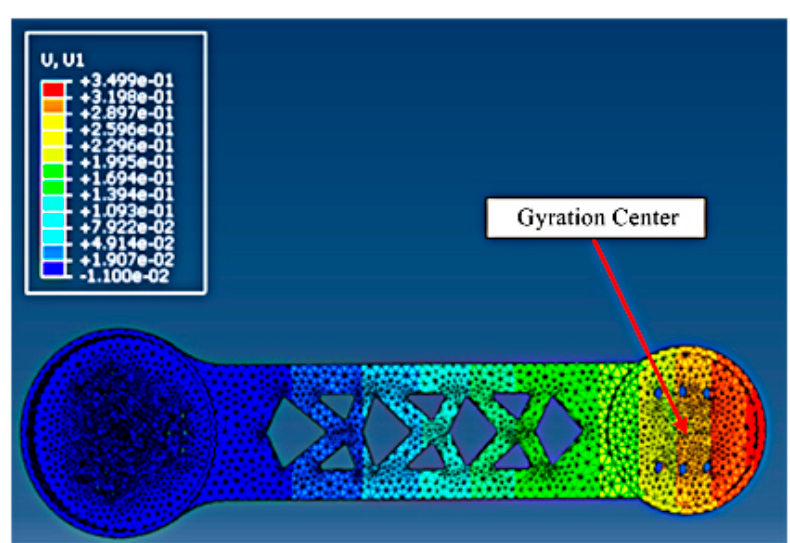
Figure 12. The maximum elastic displacement in the most unfavorable working condition.